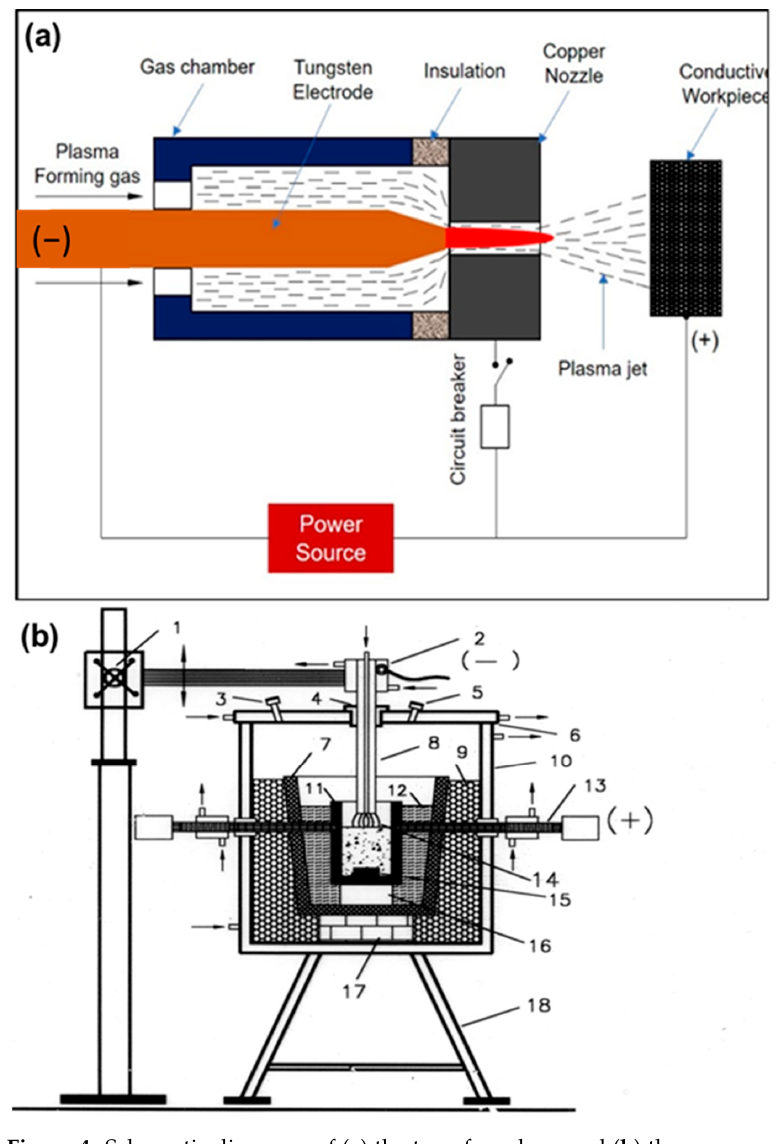
Figure 4. Schematic diagrams of ( a ) the transferred arc and ( b ) the corresponding plasma reactor.